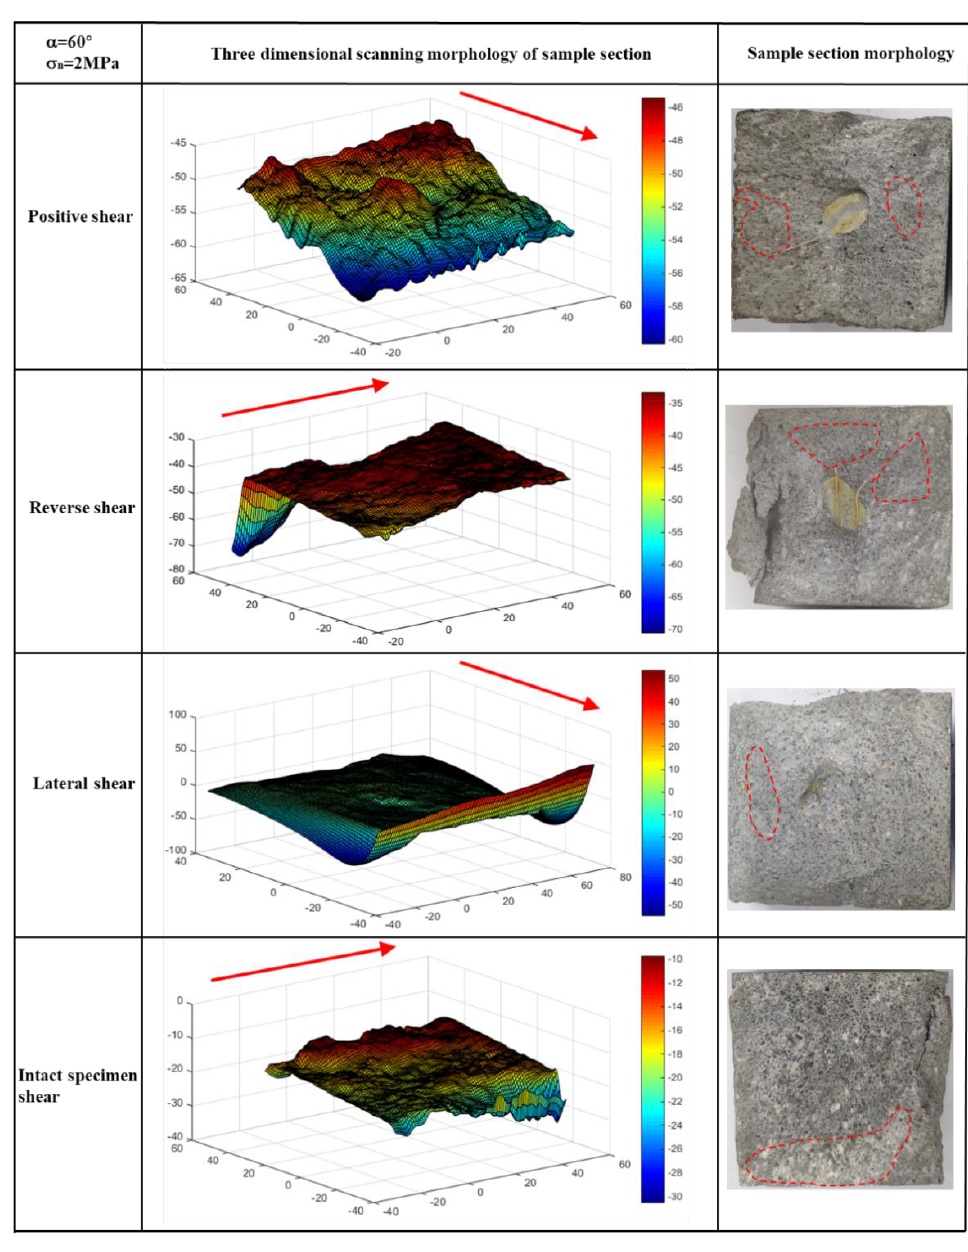
Figure 9. Comparison of 3D scanning morphology characteristics of sections from each sample after failure (σ n = 2 MPa, α = 60°).